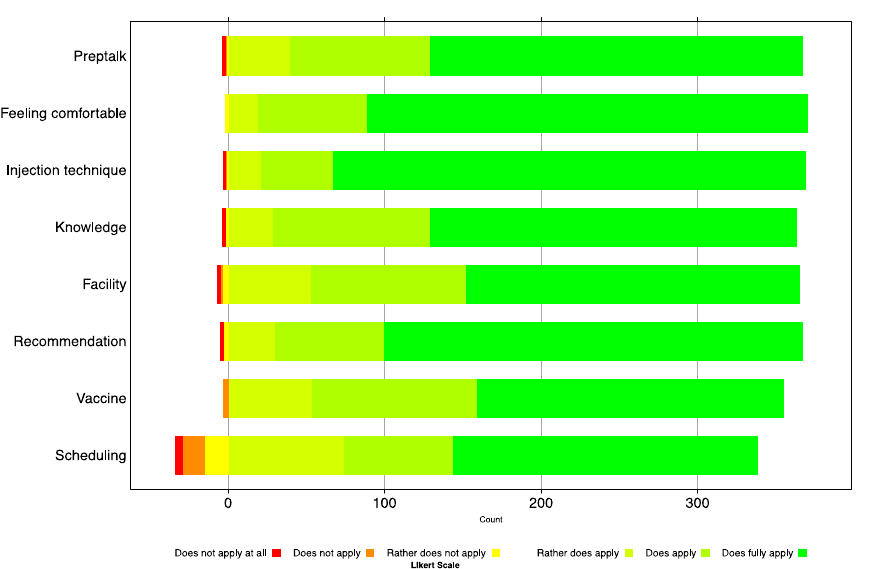
Figure 2. Frequency distribution of the answers on the satisfaction of getting vaccinated against COVID-19 in public pharmacies in the canton of Zurich (N = 372). A Likert scale of 6 + 1 was used, whereby “not answerable” was excluded.